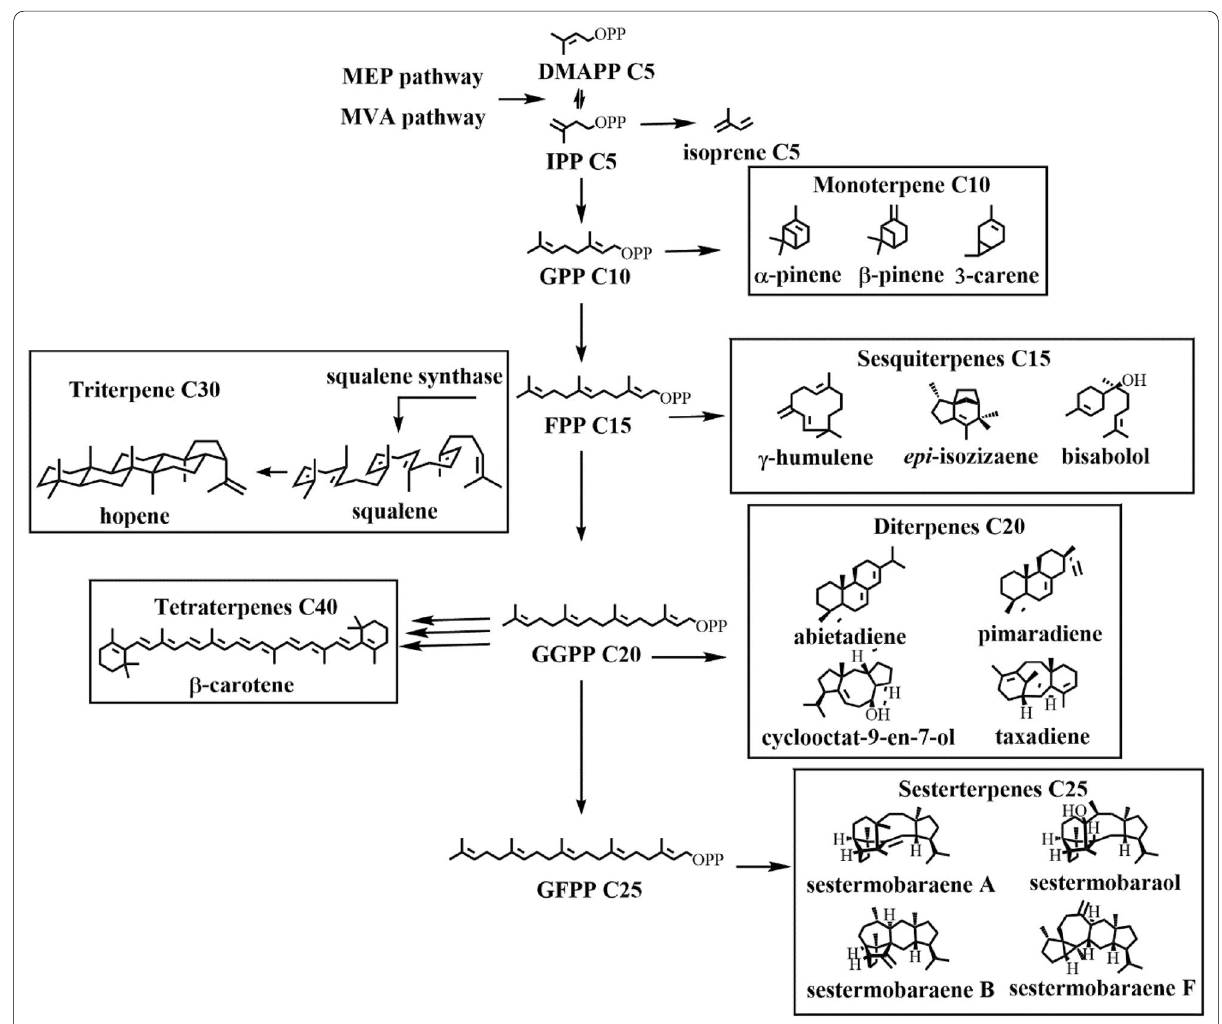
Fig. 1 Biosynthesis pathway of different terpenoids. OPP: pyrophosphate